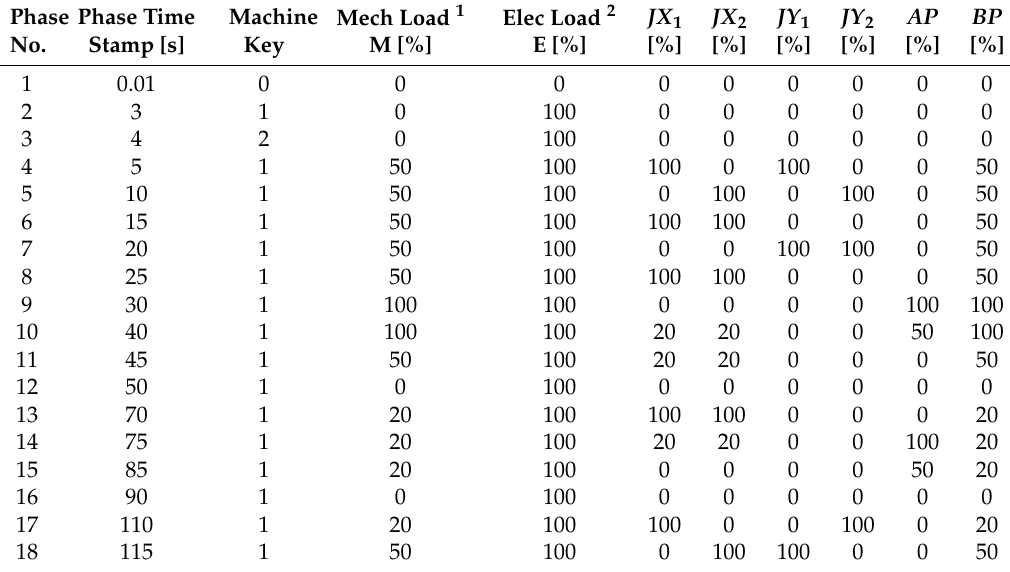
Table 5. A simulated working cycle for heavy